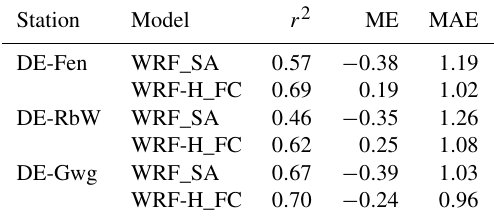
Table 7. Performance measures for 2m mixing ratio (gkg − 1 ) with simulations vs. observations for June to October